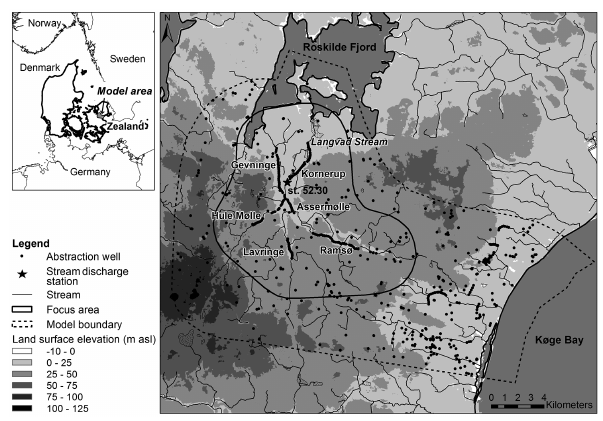
Figure 1. Model area of the Langvad Stream catchment area with land surface elevation, streams, abstraction wells and location of the main well fields in the focus area (the clusters of wells along the